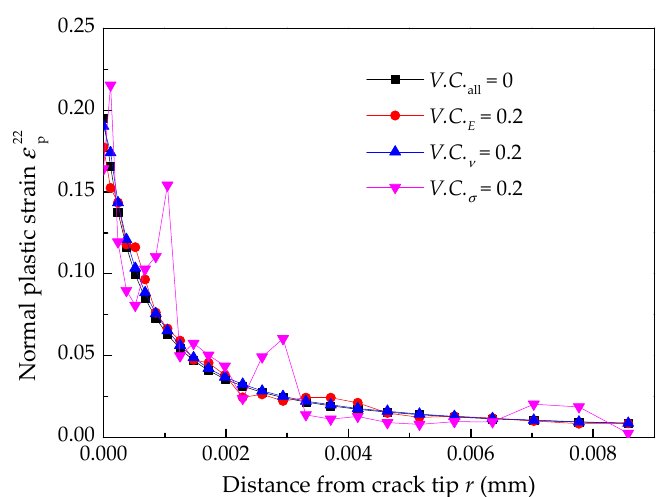
Figure 8. Normal plastic strain under a single random material factor.